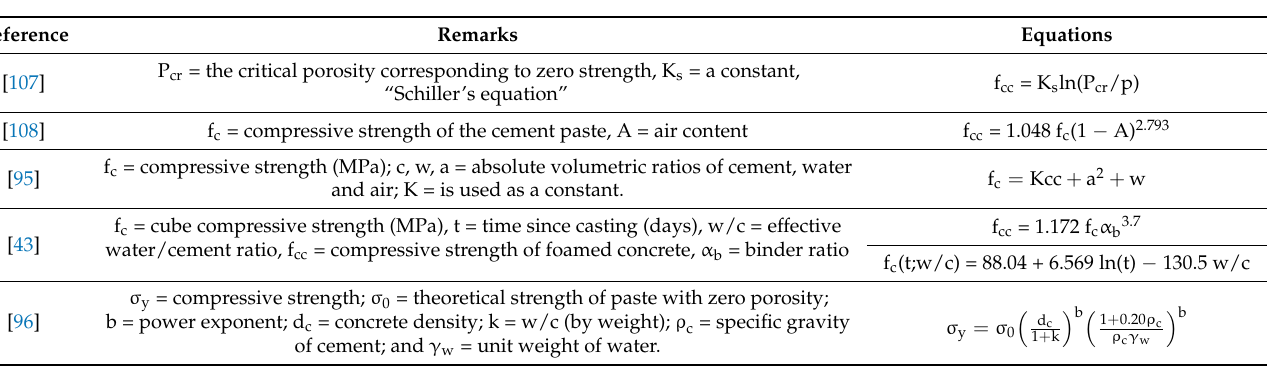
Table 10. Equations for compressive